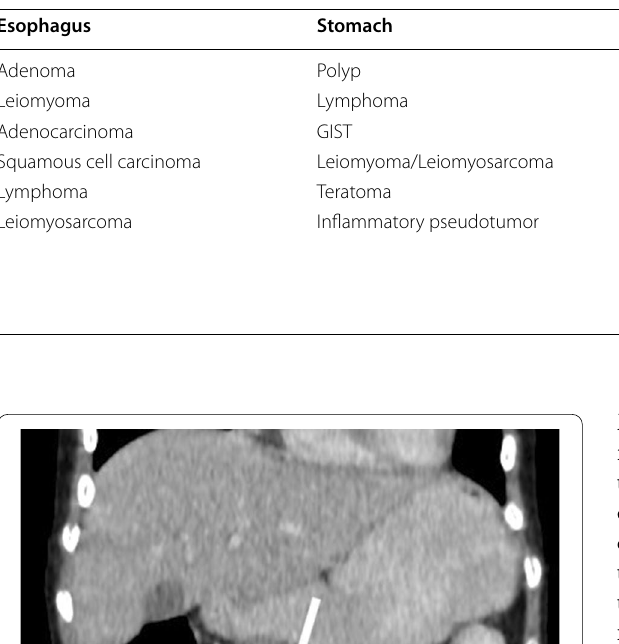
Table 1 The most frequent types of gastrointestinal tract tumors